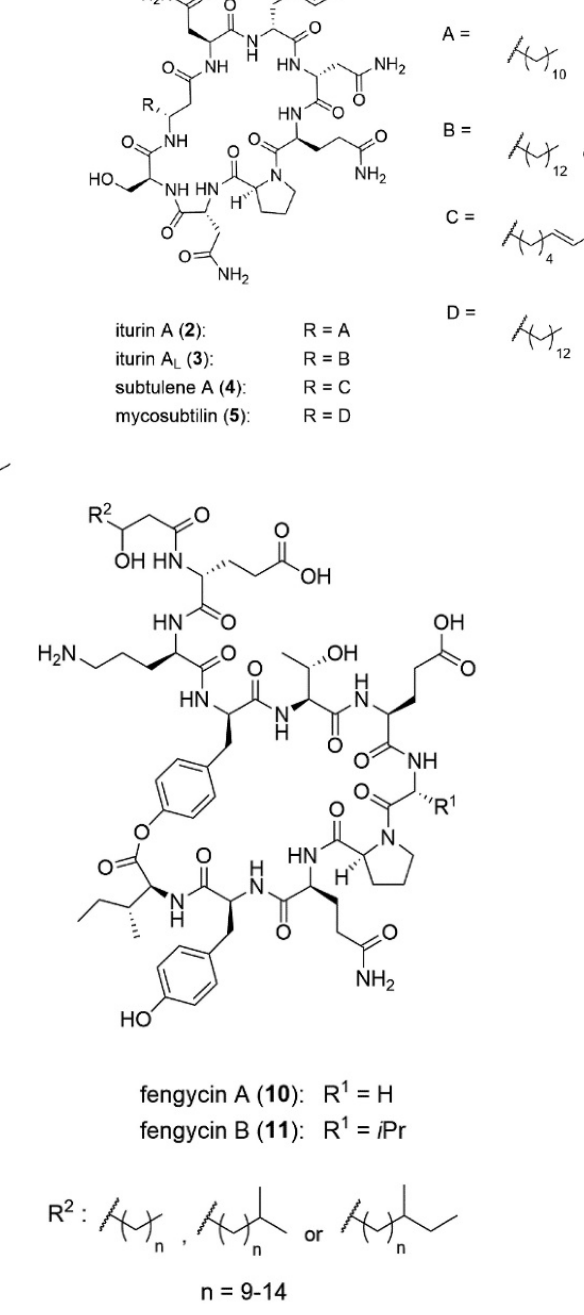
Figure 1. Chemical structures of surfactin, iturin and fengycin.